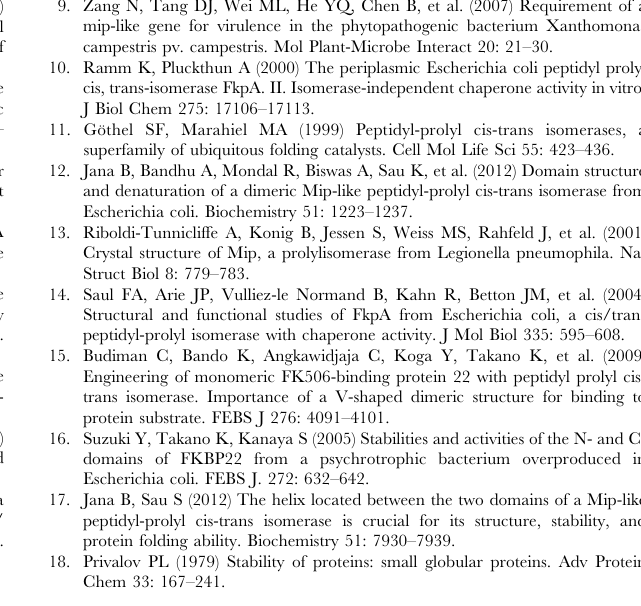
denoted native, refolded, and denatured protein are shown in panel E. (TIF) Figure S6 Unfolding of the FK506-bound/unbound rFKBP22. Samples containing rFKBP22 (pre-saturated with/ without 4 molar excess of FK506) were exposed to 0–7 M urea followed by the recording of their intrinsic Trp fluorescence spectra by a standard method. The Trp fluorescence intensity values were extracted (from the spectra), normalized and plotted against the corresponding urea concentrations. (TIF) Figure S7 Temperature-induced unfolding of the rapa- mycin-bound/unbound rFKBP22 and CTD + . The far-UV CD (A–D) and intrinsic Trp fluorescence spectra (E–H) of the indicated proteins at 25 u –95 u C are presented. (TIF) Figure S8 Refolding of the heat-treated rFKBP22. Heat- exposed rFKBP22 (pre-equilibrated with/without rapamycin) was refolded followed by its analysis using trypsinolysis (A), far-UV CD spectroscopy (B), intrinsic Trp fluorescence spectroscopy (C), and RNase T1 refolding assay (D). The native and denatured rFKBP22 were used in the study as controls.